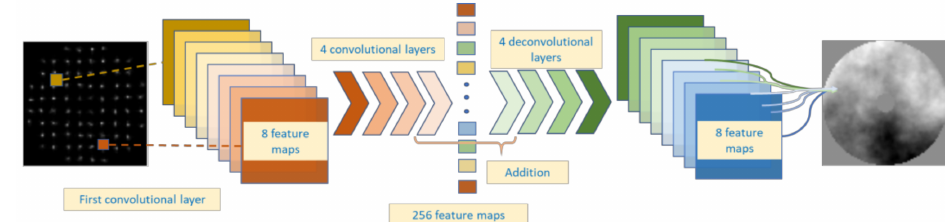
Figure 3. Schematic representation of the topology of the FCN used in the research. An image is set as an input; through the convolutional block, kernels are applied to obtain feature maps. After processing with several convolutional layers, recovering of the information is performed with deconvolutions and adding form previous characteristics up to the desired